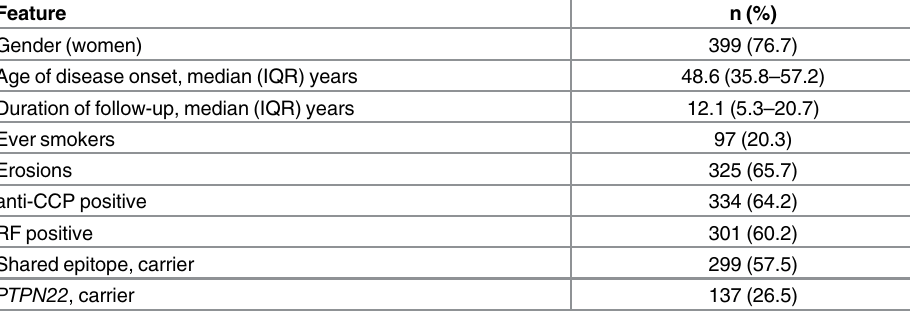
Table 1. Characteristics of the patients with RA included in the